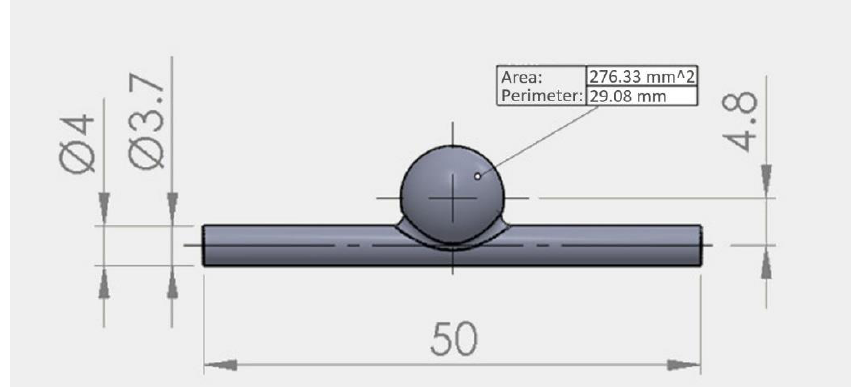
Figure 1. Studied IA model.